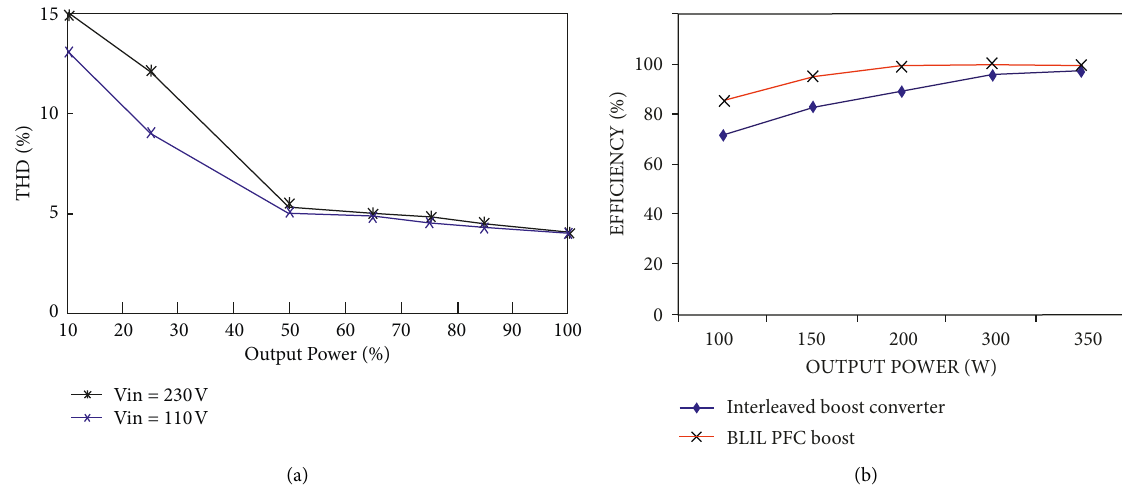
� 110V and V � 230V. (b) Efficacy of the converter under variable in in